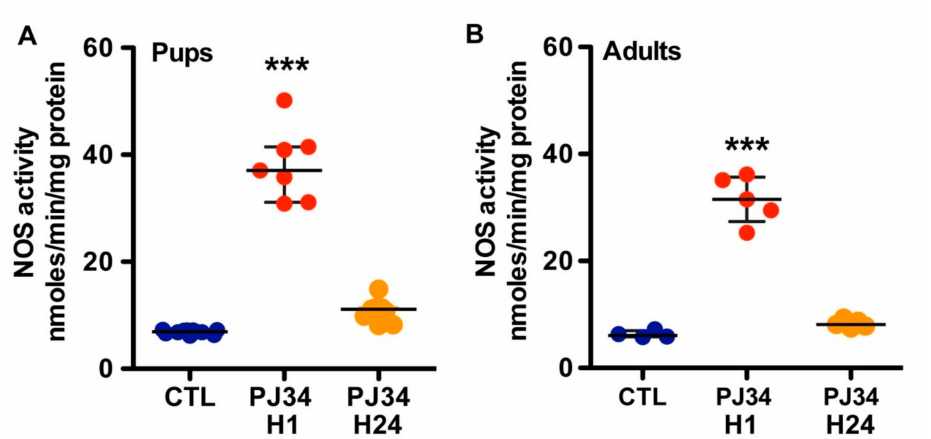
Figure 3. NOS activity in brain tissues from neonatal and adult mice in control conditions and after PJ34 administration (at 1 and 24 h). NOS activity in pup ( A ) and adult ( B ) mice is reported in nmol / min / mg protein and data were presented as the median and 25th–75th percentiles ( n = 5–7). (*** p < 0.001 vs. the control (CTL) group).